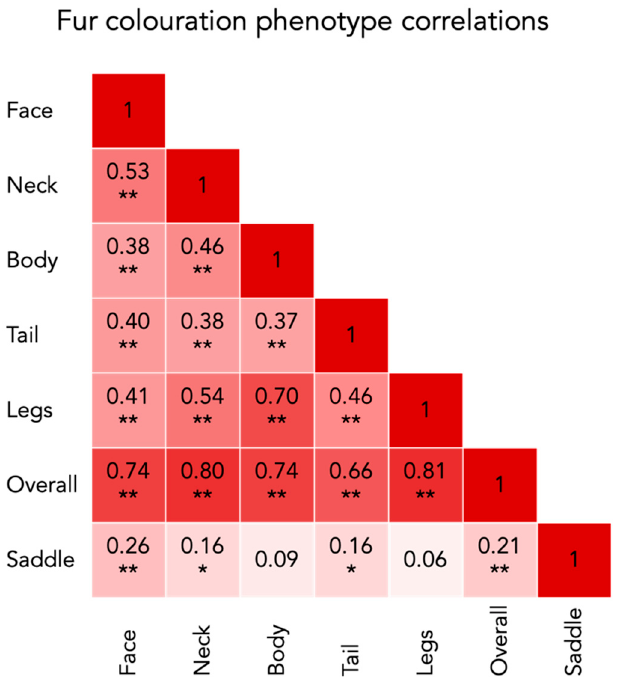
Figure 1. The frequency (count) of individuals for each phenotype scoring. The total number of individuals is 190 with Table 187 due to the exclusion of three dogs that did not express the saddle.